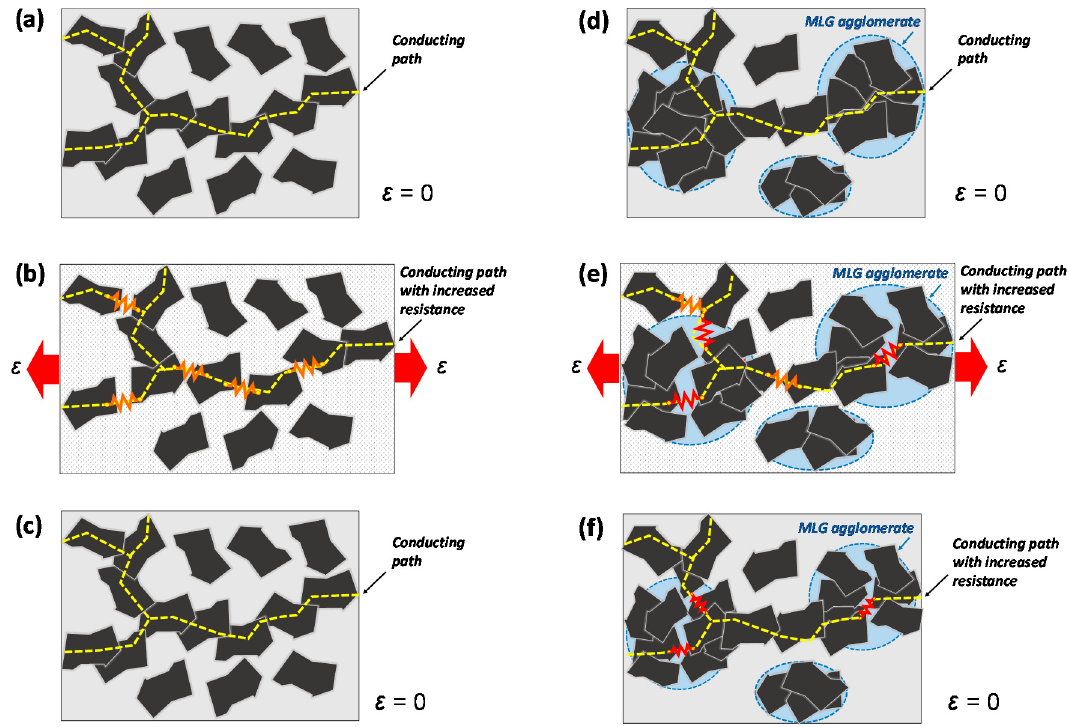
Figure 8. Schematic representation of the role of MLG agglomerates on the conductive network changes in a composite, subjected to loading and unloading: composite in which the presence of MLG agglomerates is negligible ( a – c ) or not ( d – f ).